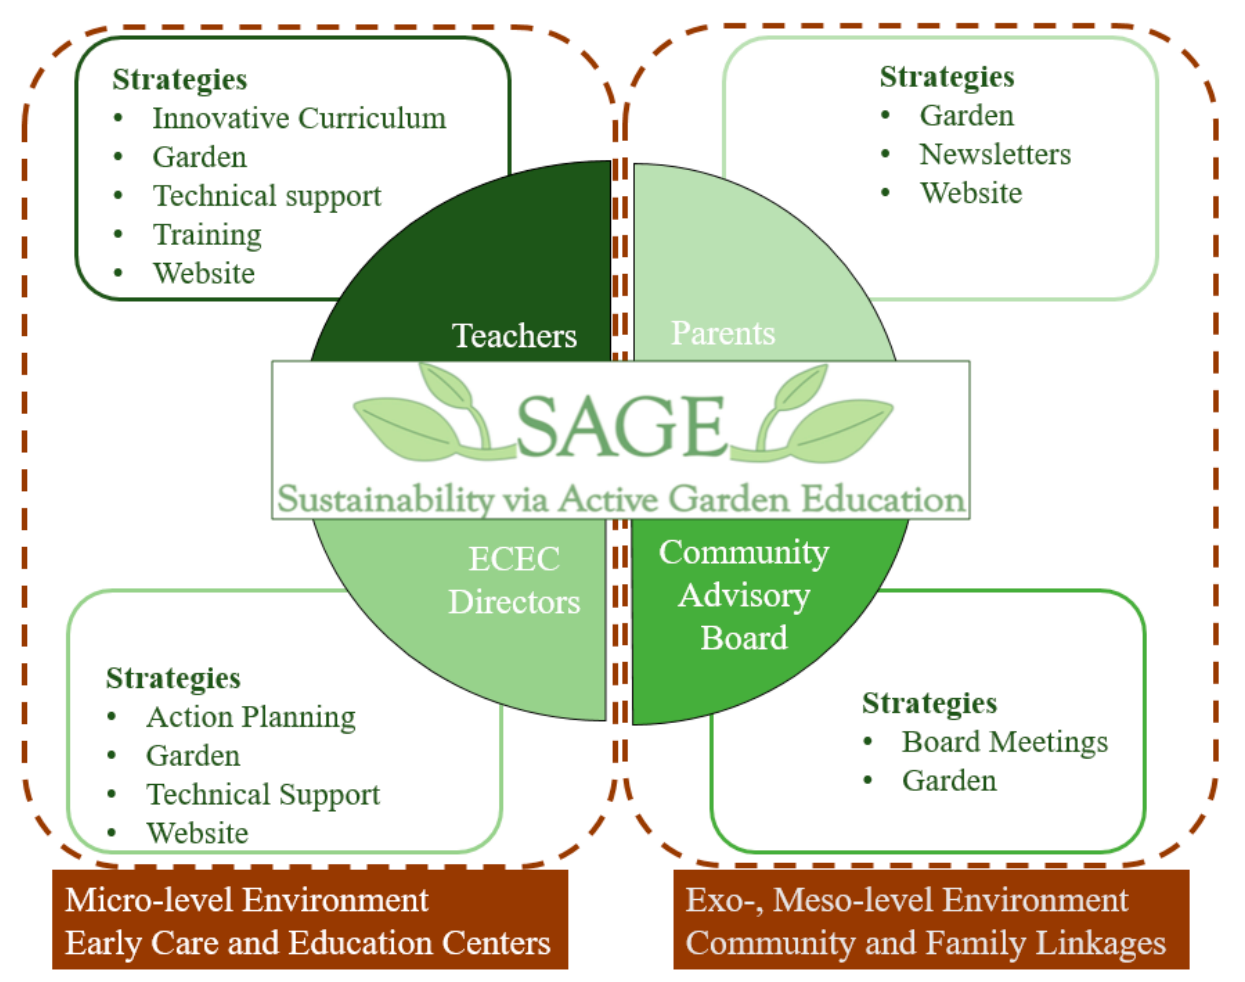
Figure 1. Strategies by stakeholder framed by ecologic level in the SAGE SAP.